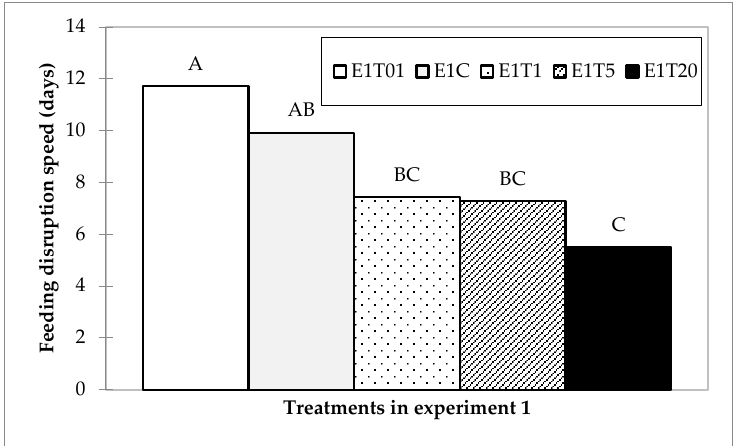
Figure 4. Summary of the Tukey multiple pairwise comparison of the disruption speed differences between treatments with a confidence interval of 95%.